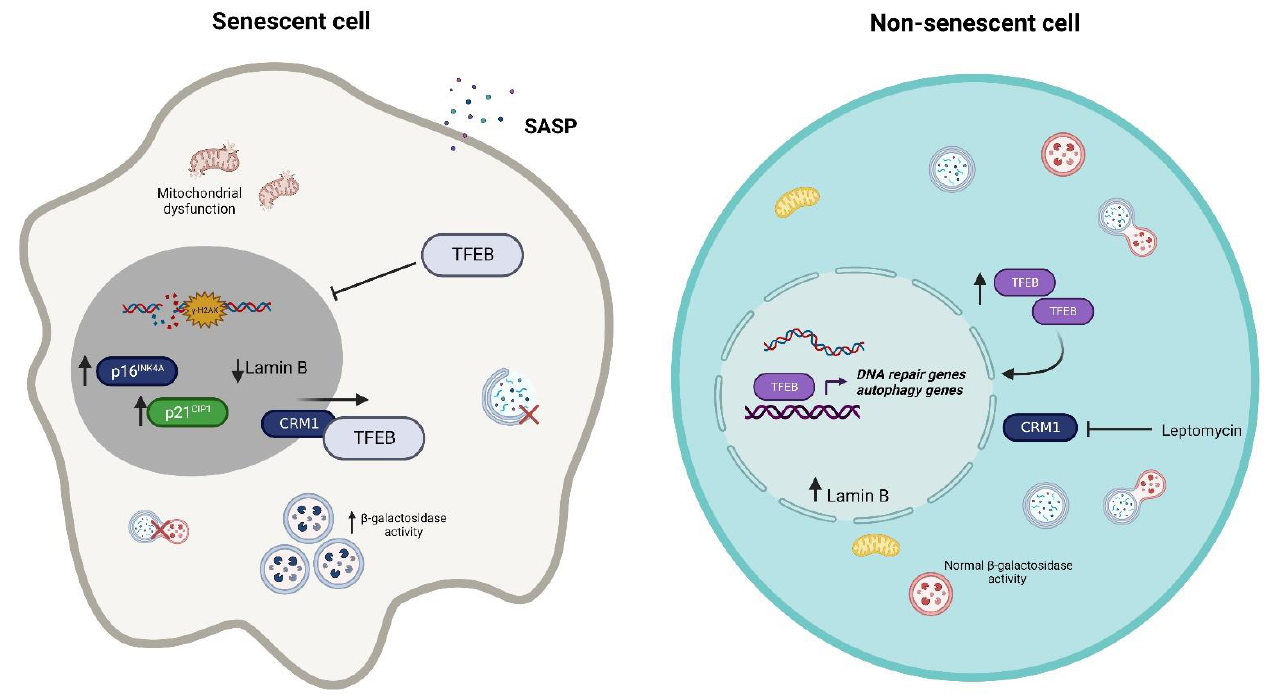
Figure 2. The TFEB activation can influence the induction of senescence. Decreased nuclear TFEB localization may be one of many causes of senescence; however, restoring TFEB nuclear activity could contribute to avoiding cellular senescence, perhaps through the induction of autophagy or DNA repair genes.